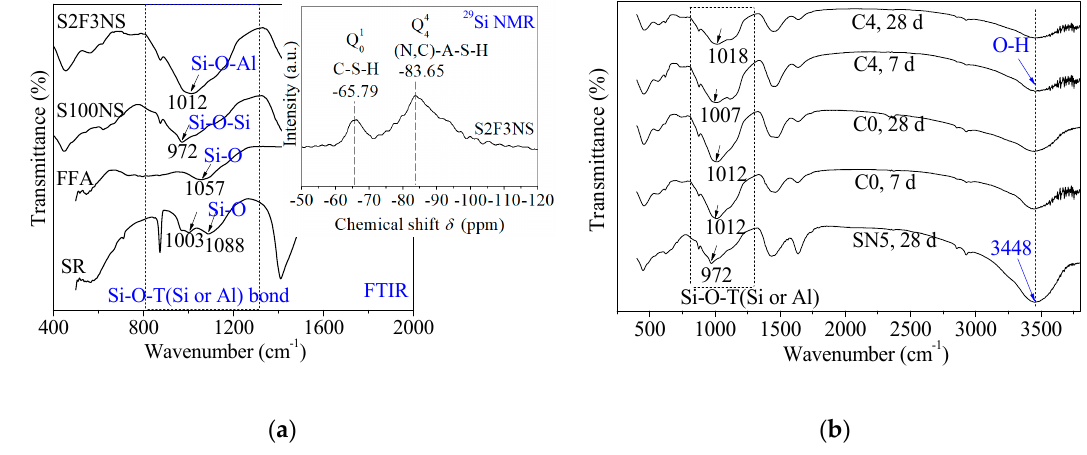
Figure 6. ( a ) Fourier transform infrared (FTIR) spectra of FFA, SR, control S100NS and paste S2F3NS at 180 d, and 29 Si NMR spectrum of paste S2F3NS at 180 d from reference [24]. ( b ) Chemical bonds analysis of control C0 (SR-FFA-NS system) and paste C4 (SR-FFA-BHG-NS system) at 7 d and 28 d through FTIR spectra.